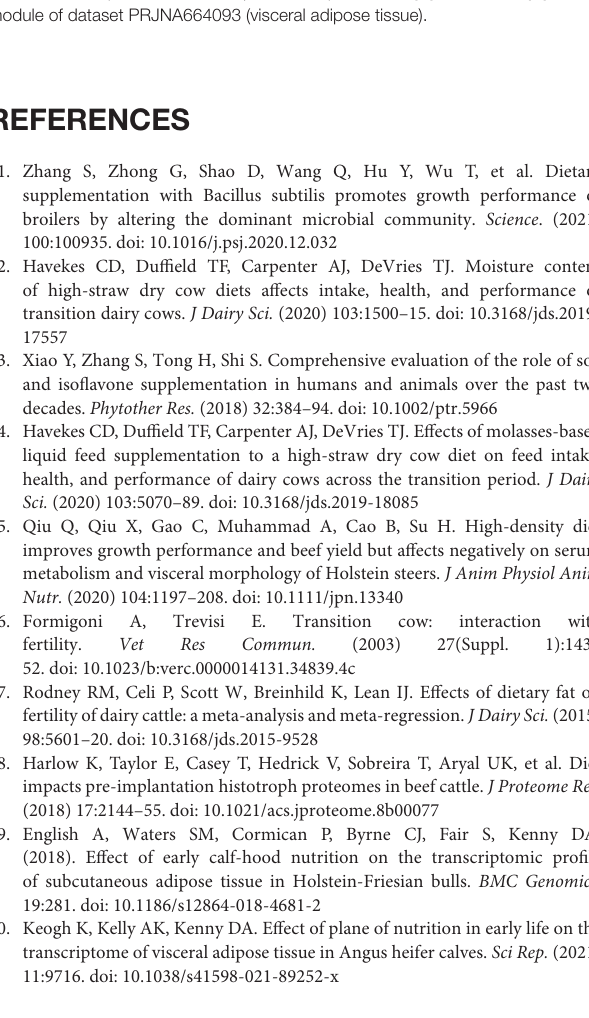
Supplementary Figure 1 | Sample dendrogram and trait heatmap in PRJNA382633 (left) and PRJNA664093 (right). Supplementary Figure 2 | Gene co-expression networks in subcutaneous adipose tissue (PRJNA382633). (A) Analysis of the scale-free fit index for soft-thresholding powers (left) and the mean connectivity for various soft-thresholding powers (right); (B) Network heatmap plot in the co-expression modules. (C) Gene clustering dendrogram and module identification. Supplementary Figure 3 | Gene co-expression networks in visceral adipose tissue (PRJNA664093). (A) Analysis of the scale-free fit index for soft-thresholding powers (left) and the mean connectivity for various soft-thresholding powers (right); (B) Network heatmap plot in the co-expression modules. (C) Gene clustering dendrogram and module identification. Supplementary Figure 4 | The relationships among the module eigengenes and nutritional levels in subcutaneous adipose tissue (left) and visceral adipose tissue (right). Supplementary Figure 5 | Top 50 hub genes identified by Betweenness, Degree, EPC, and MNC in the blue (A) and yellow (B) module of dataset PRJNA382633 (subcutaneous adipose tissue), and blue (C) and brown (D) module of dataset PRJNA664093 (visceral adipose tissue).